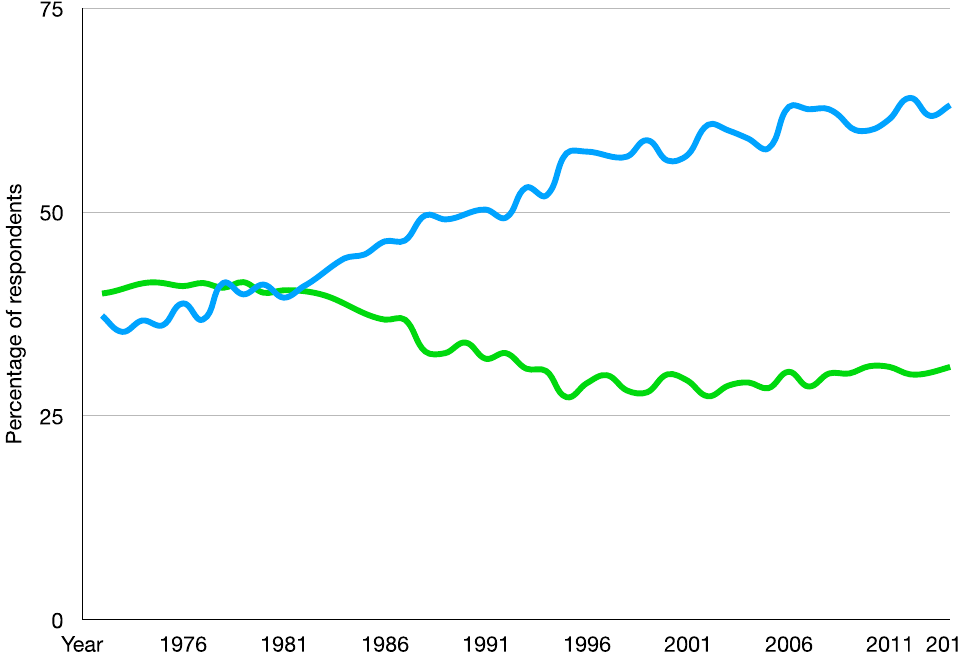
Figure 11. Long-term shift in life goals from material to non-material wellbeing in the Japanese public [57].